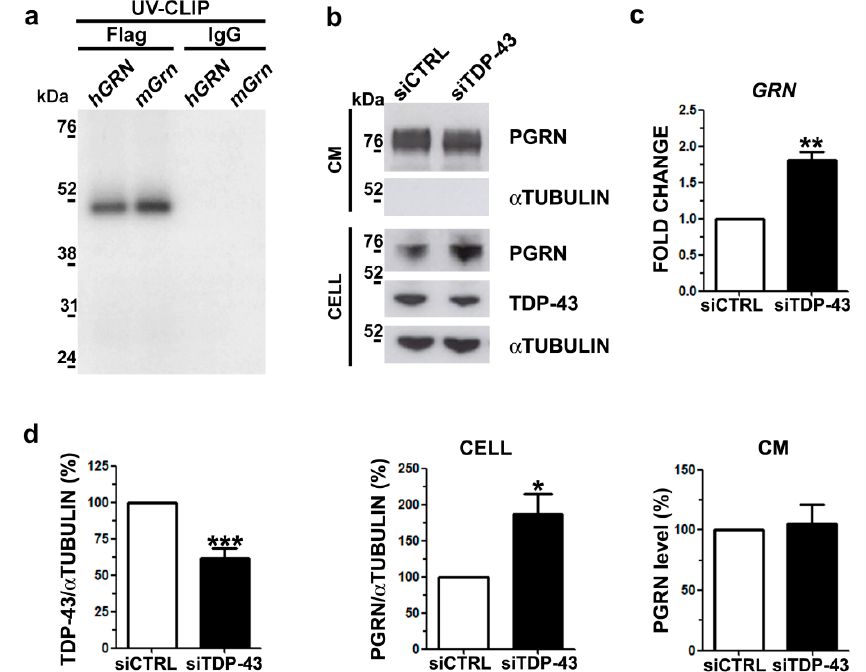
Figure 3. PGRN protein content and secretion in human TDP-43 LOF cells. ( a ) SDS-PAGE showing the results of the UV-crosslinking immunoprecipitation (UV-CLIP) experiment using HEK293T protein lysates overexpressing the human recombinant Flag-TDP-43 protein and the P 32 -radiolabelled murine and human GRN 3 (cid:48) UTR riboprobes. The murine riboprobe was used as positive control and the anti-IgG antibody as a negative control for immunoprecipitation. ( b ) Representative WB images showing TDP-43 and PGRN immunoblots of cellular lysates (CELL) and conditioned media (CM) in human M17 cells upon TDP-43 gene silencing. α Tubulin was used for data normalization of intracellular protein content and as non-secreted control protein in CM. ( c ) Real time quantification of GRN mRNA upon TDP-43 knock-down in human neuroblastoma M17 cells (mean ± s.e.m.; n = 3 independent experiments; two-tailed unpaired t test; ** p < 0.01). ( d ) Densitometric and statistical analysis of WB data shown in b ) (mean ± s.e.m.; n = 5 independent experiments; two-tailed unpaired t test; * p < 0.05; *** p <